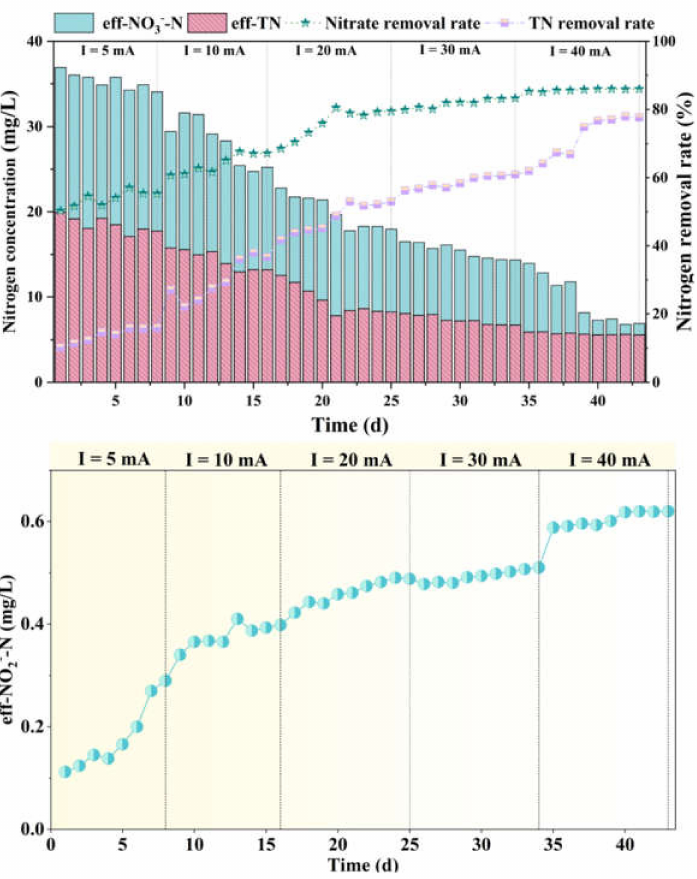
Figure 3. Concentrations of NO − different current